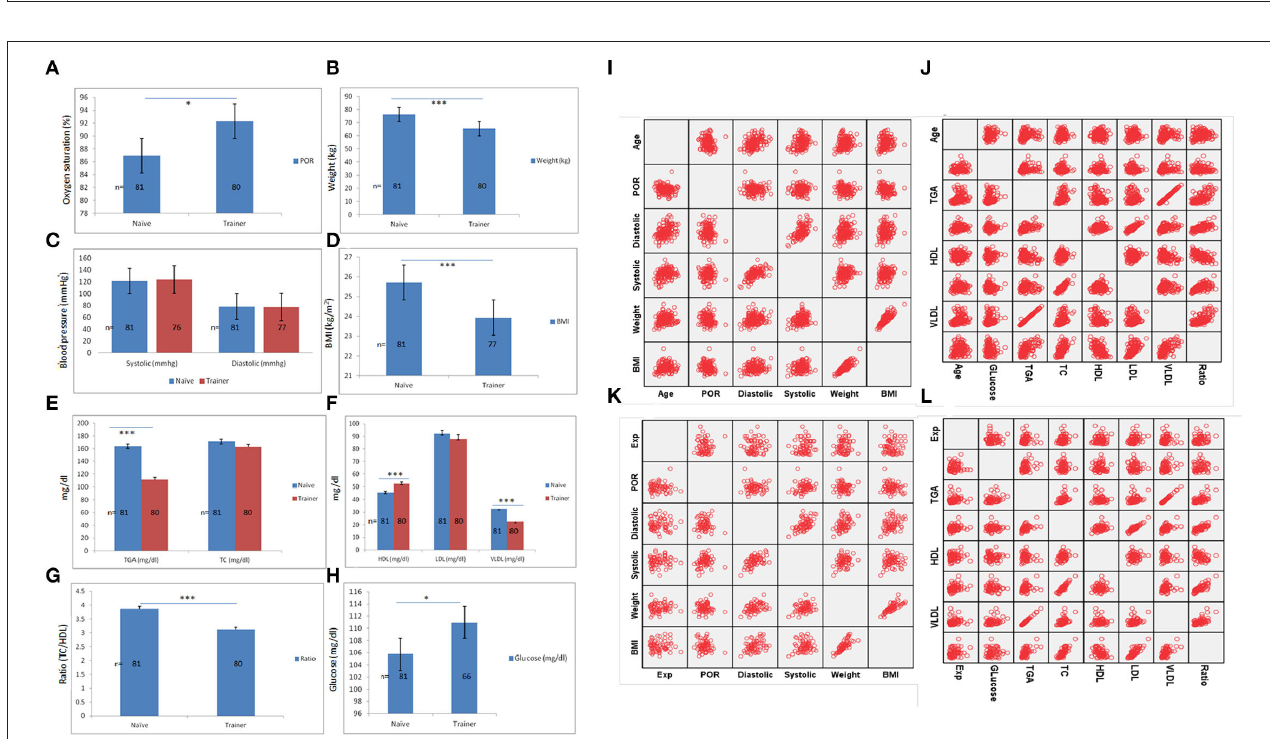
FIGURE 3 | Physiological-biochemical measurements and comparison between naïve and trainer groups. Various physiological parameters of naïve participants before yoga exposure including (A) POR, (B) weight, (C) blood pressure (systolic and diastolic), and (D) BMI and its comparison with trainer groups. Biochemical analysis of same naïve participants for (E) TG and TC (mg/dl), (F) HDL, LDL, and VLDL (mg/dl), (G) ratio (TC/HDL), and (H) serum glucose levels (mg/dl) and further compared with trainer group shown significant alteration in various important metabolic pathways. (I,J) The scatter-plot matrix is showing the correlation of age with physiological and biochemical parameters analyzed by bivariate correlation analysis. (K,L) Scatter-plot matrix is showing the correlation of yoga experience on various anthropometric and biochemical values. *Statistical significance ≤ 0.05, **statistical significance 0.001 and ***statistical significance < 0.0001. Bar is showing standard error mean